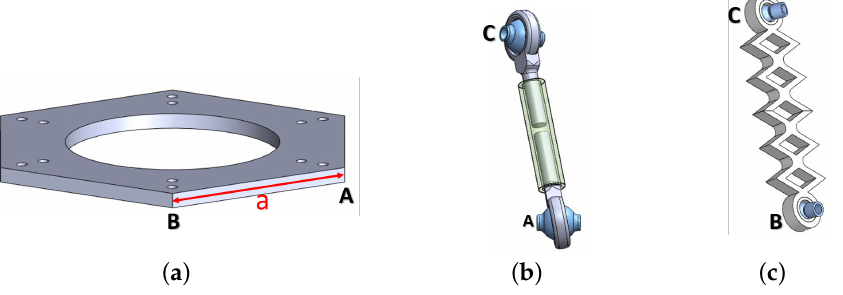
Figure 4. Components of the triangulated polyhedron prototype. ( a ) Constant base a . ( b ) Length l AC , greater displacement. ( c ) Length l BC , minor displacement.